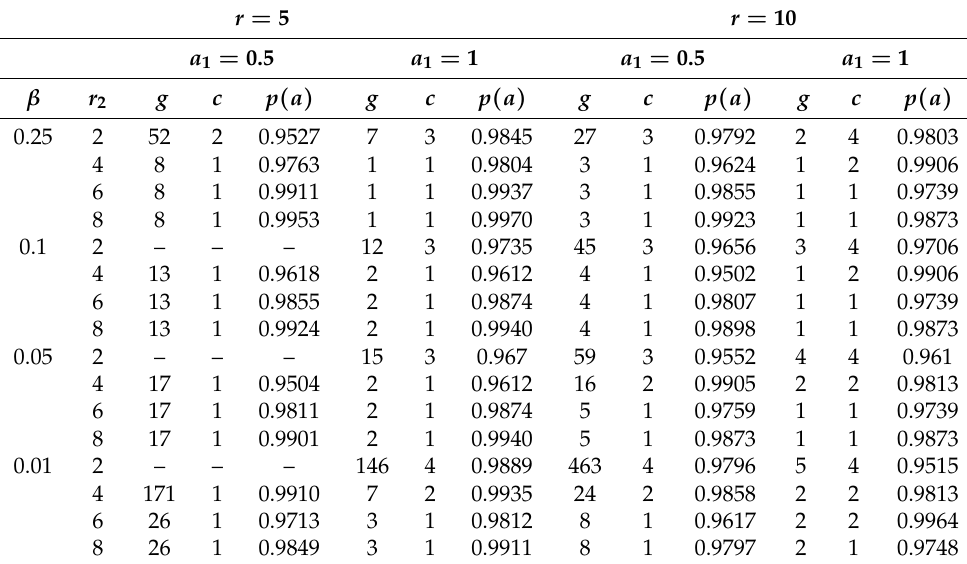
Table 2. GASP under CBellW model, β = 1 and λ = 1.50.